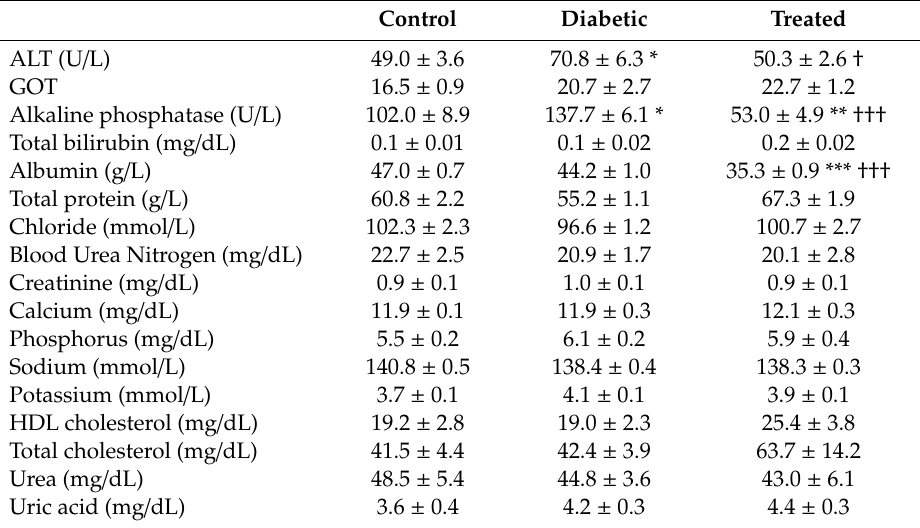
Table 1. In vivo toxicity of pterostilbene (50 mg /